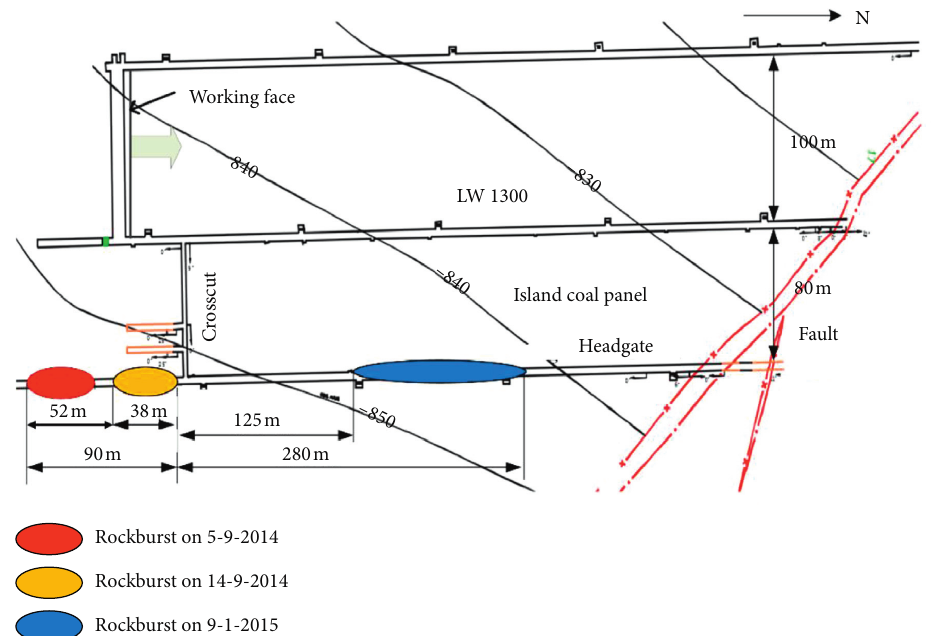
Figure 2: Layout of the stope in Longyun coalmine and rockburst areas on 5th September 2014 (a), 14th September 2014 (b), and 1st September 2015